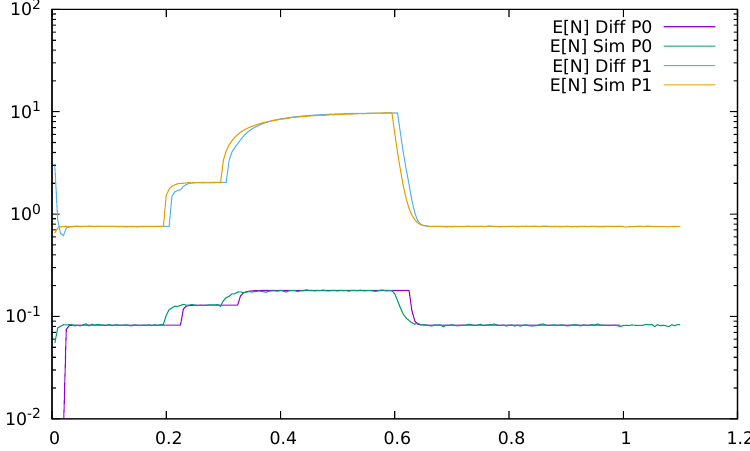
Figure 23. Mean queue length at the switch for priority (P0) and non − priority (P1) packets as a function of time, (cid:101) = 0.2, diffusion, and simulation results.